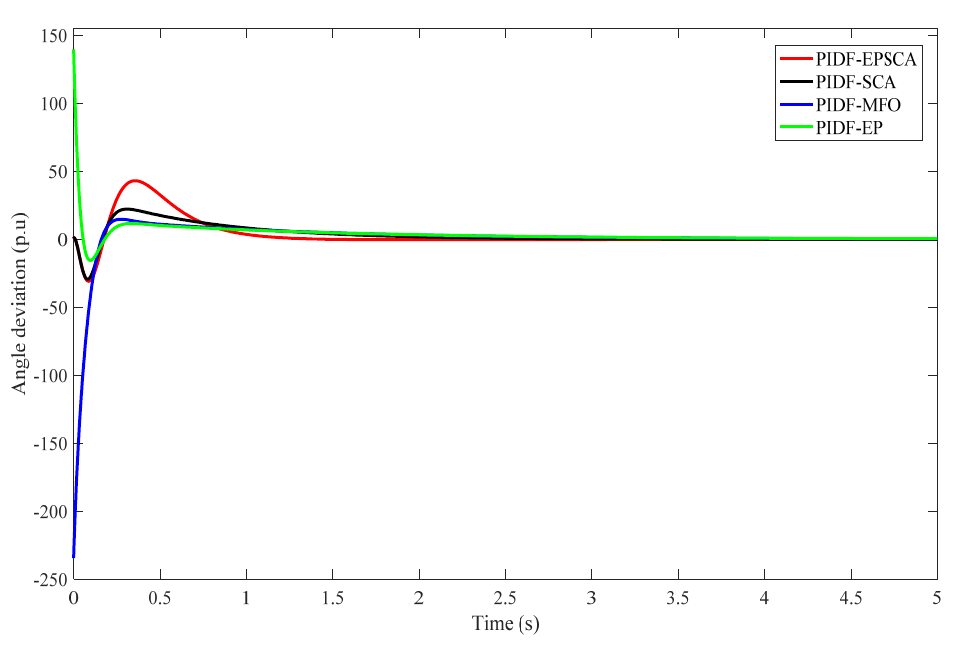
Figure 15. Angle deviation response of the TCSC-PIDF controller using PIDF-EPSCA, PIDF-SCA, PIDF-MFO, and PIDF-EP techniques for Scenario A-1.